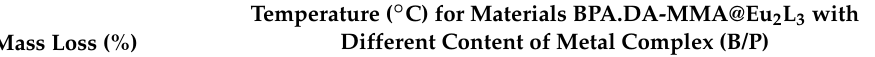
Table 2. Comparison of thermal behavior of investigated materials in the form of block (B) and powder (P) in air atmosphere.